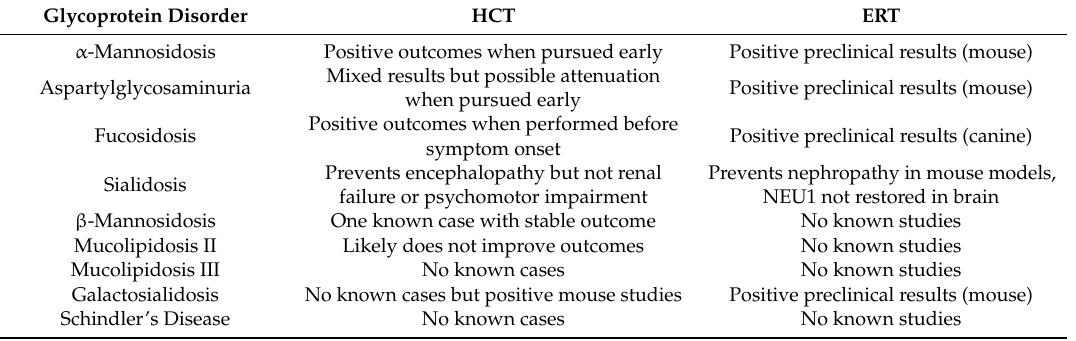
Table 1. Summary of glycoprotein disorders and outcomes with Hematopoietic cell transplant (HCT) or enzyme replacement therapy